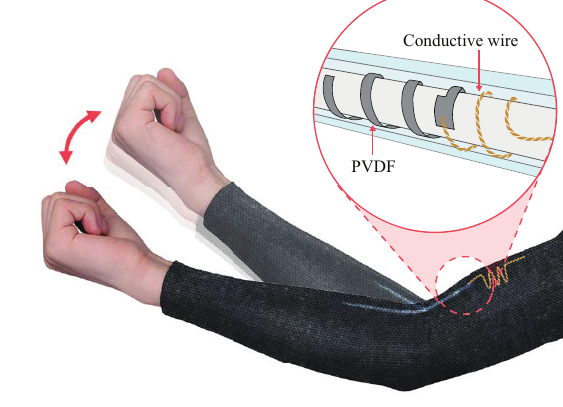
Figure 9. Concept schematic of the sensor woven into clothing measuring the joint angle of the